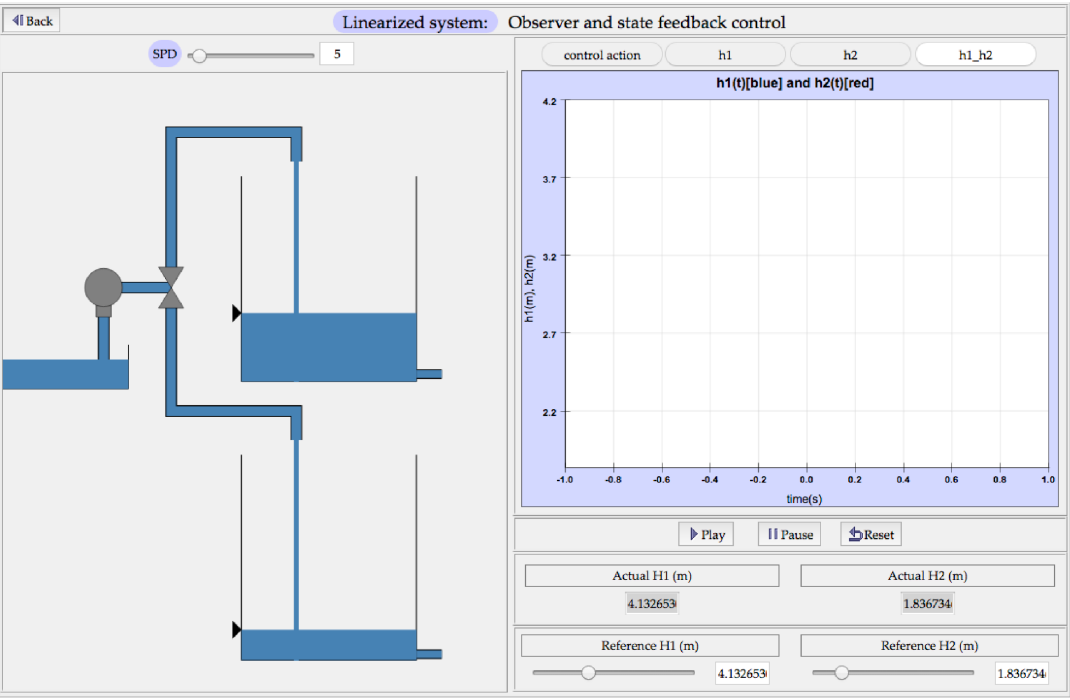
Figure 7. Simulation of the controlled system.